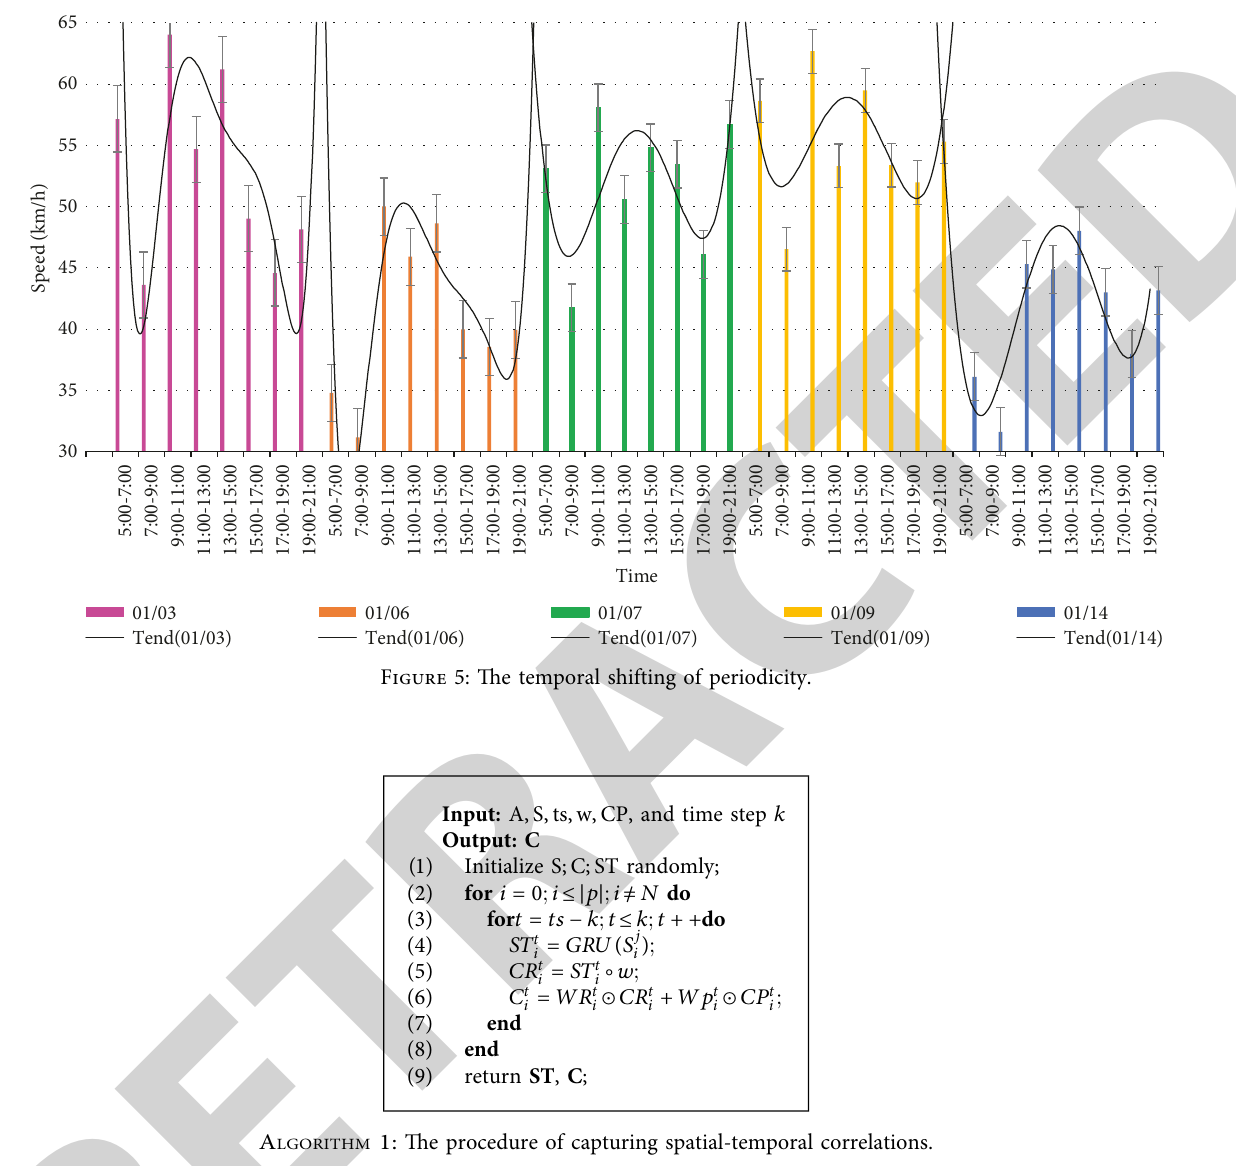
Figure 5: The temporal shifting of